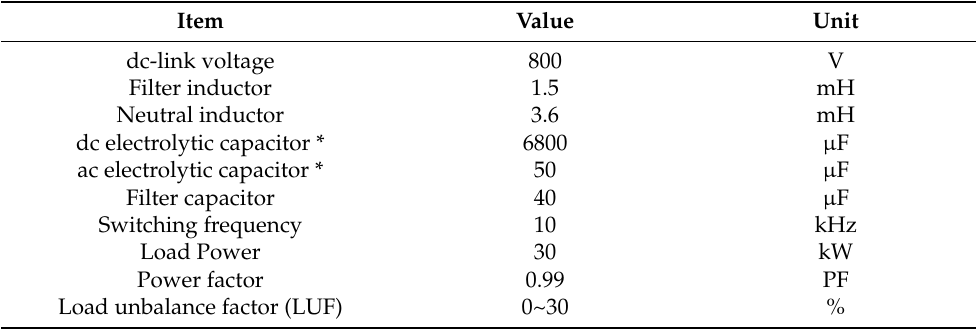
Table 1. Simulation and experiment